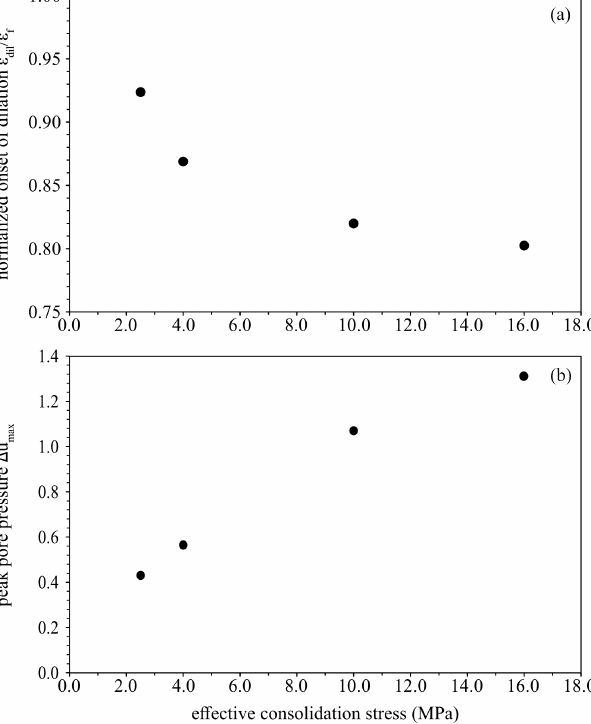
Figure 11. (a) Axial strain at the onset of (net) dilation normalised by the respective axial strain at failure indicates an earlier (net) dila- tion at higher effective stresses. (b) Maximum change in pore water pressure during undrained loading increases with higher effective stresses. Both graphs show a strong